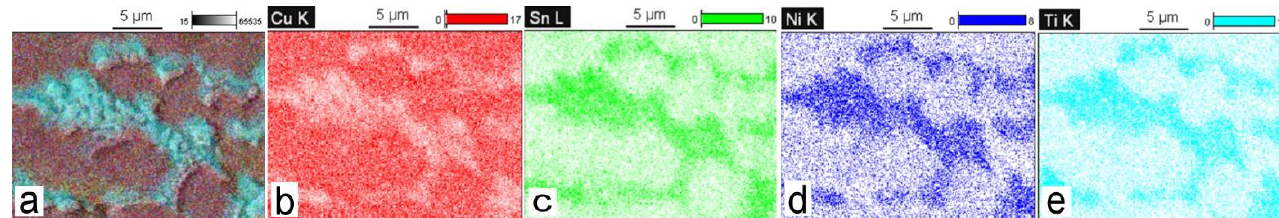
Figure 7. Element distribution maps for CuSn8Ni3Ti2 alloy, with separation of the intermetallic phase: ( a ) maps of elements; ( b ) Cu; ( c ) Sn; ( d ) Ni; ( e ) Ti. Table 5. Chemical composition EDS wt.% of CuSn8Ti2 alloy for the Figure 6b image.